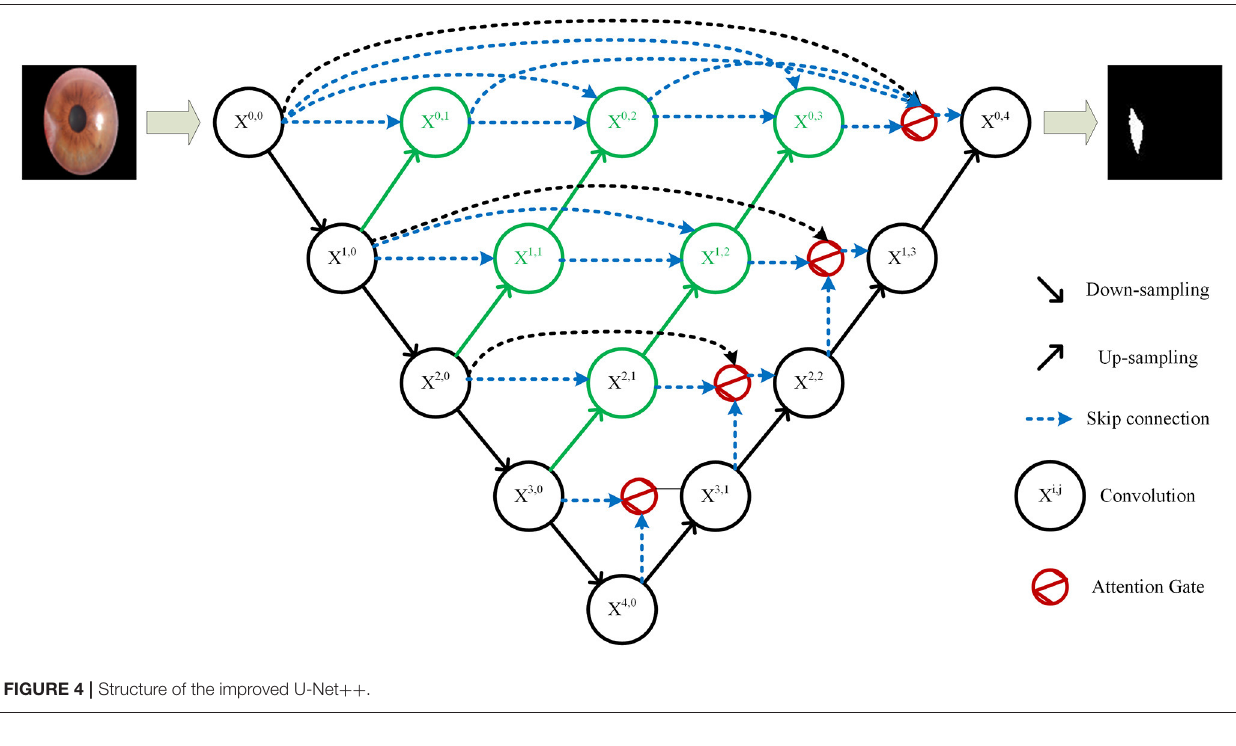
FIGURE 4 | Structure of the improved U-Net ++ .